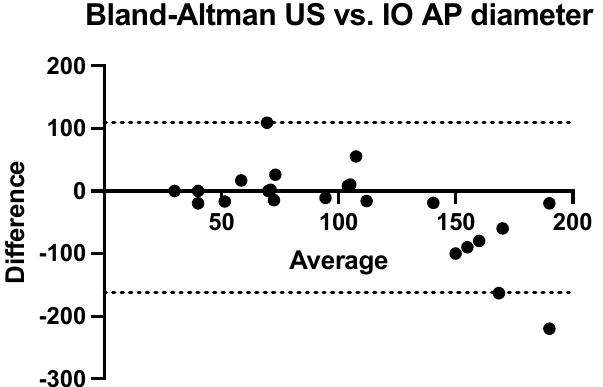
Figure 4. Spearman correlation coefficient (US = ultrasound, TC = computed tomography, IO = in- traoperatively).